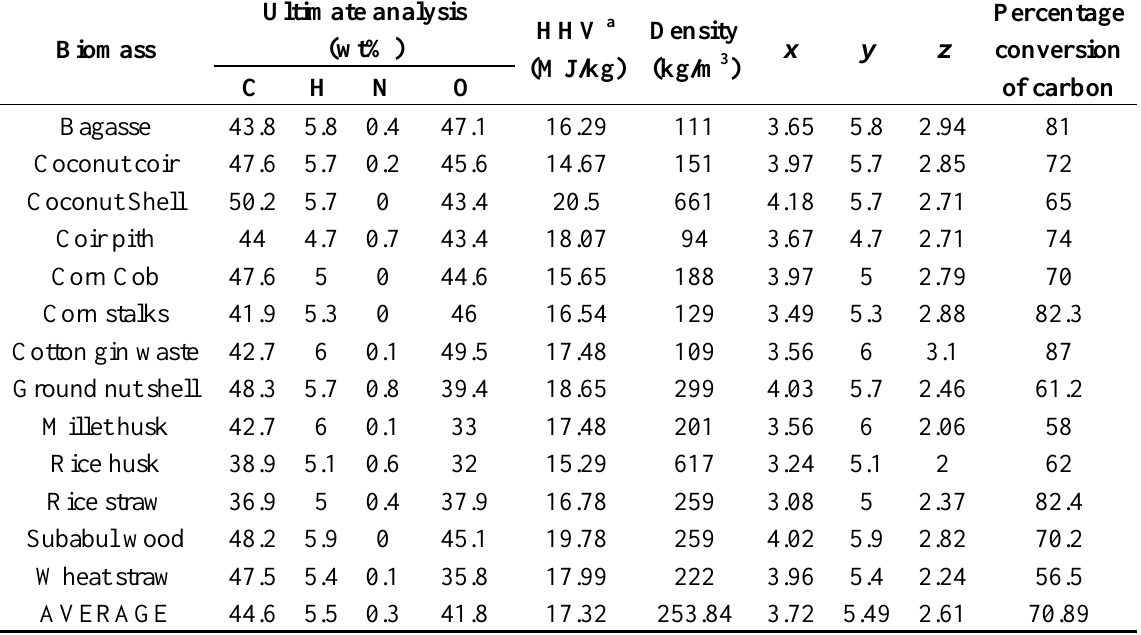
Table 1. Ultimate analysis of biomass